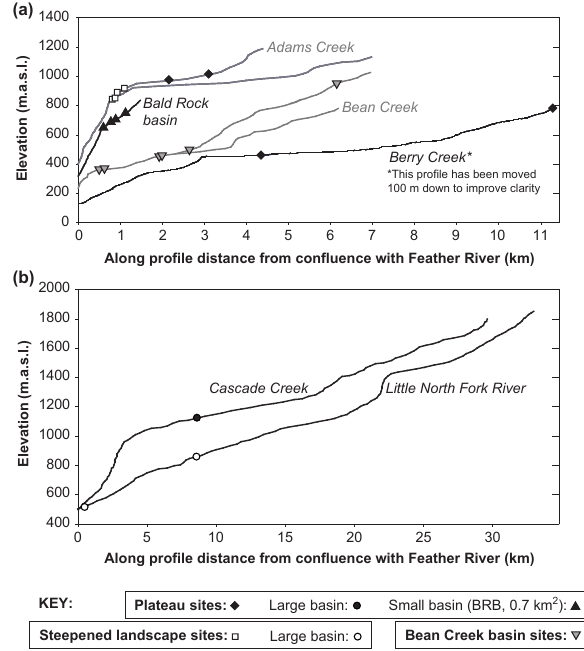
Figure 5. Long profiles of the studied rivers with location of the Figure 5: Long profiles of the studied rivers with location of the sampling sites for fluvial sampling sites for fluvial sediment. (a) Small tributary basins of sediment. (a) Small tributary basins of the Feather River (length < 12 km). (b) Two large the Feather River (length < 12km). (b) Two large tributaries of the tributaries of the Feather River (note change in scale on x-axis). We classify sites based on their position with respect to the topographic break in slope (see key); Bean Creek sites are Feather River (note change in scale on the x axis). We classify sites treated separately due to the lack of clear morphological distinction between relict surface based on their position with respect to the topographic break in and steepened landscape. slope (see key); Bean Creek sites are treated separately due to the lack of a clear morphological distinction between relict surface and steepened landscape.